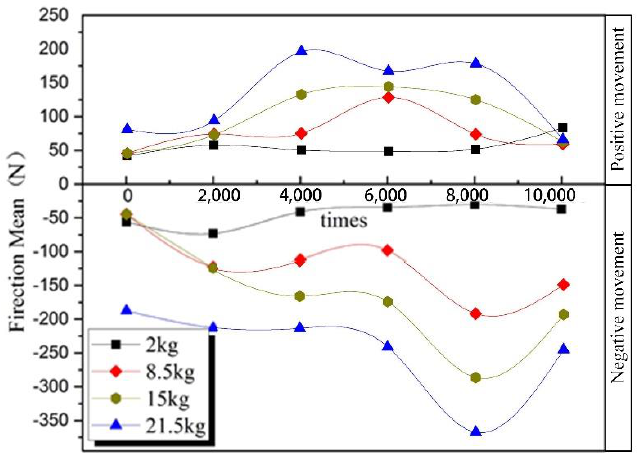
Figure 6. At 70 °C, 5 mm/s, the friction force with different positive pressure. Figure 6. At 70 ◦ C, 5 mm / s, the friction force with di ff erent positive